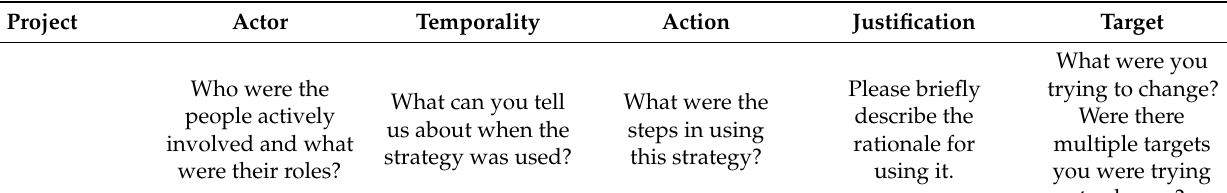
Figure 2. Number of projects implementing each of the 72 ERIC strategies. Table 1. Specification of “obtaining and using stakeholder feedback” implementation strategy by IGNITE 1 genomic medicine implementation